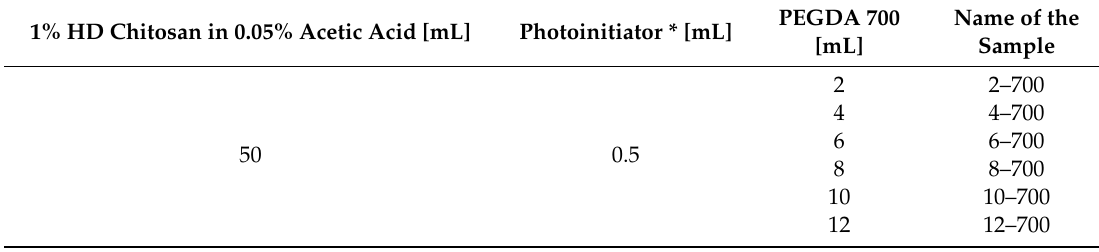
Table 2. Compositions of hydrogels prepared using PEGDA 700 as a crosslinking agent. 1% HD Chitosan in 0.05% Acetic Acid [mL]